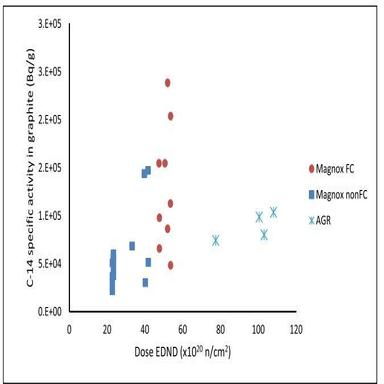
C-14 specific activity in the graphite from Magnox and AGR cores against irradiation dose.